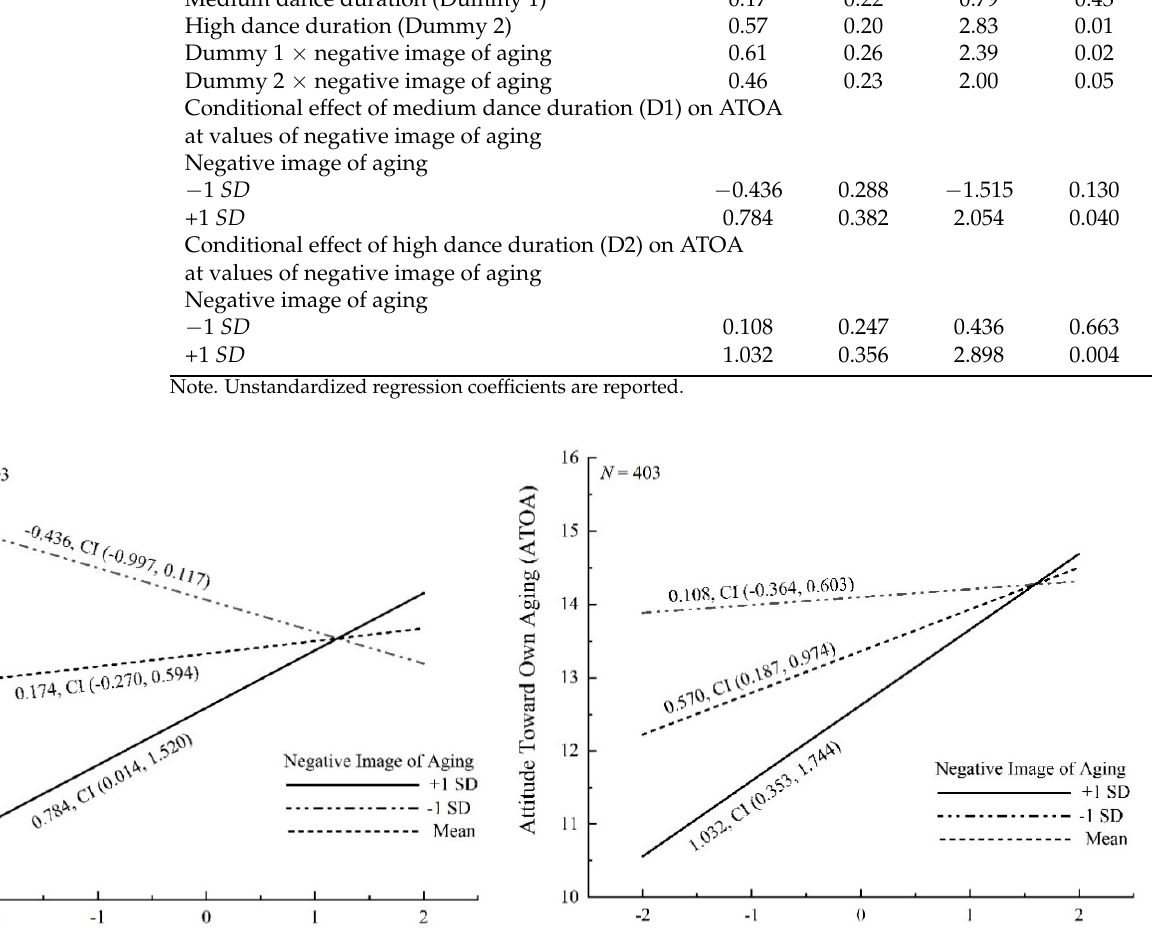
Table 3. Regression results on QoL in model with negative image of aging.